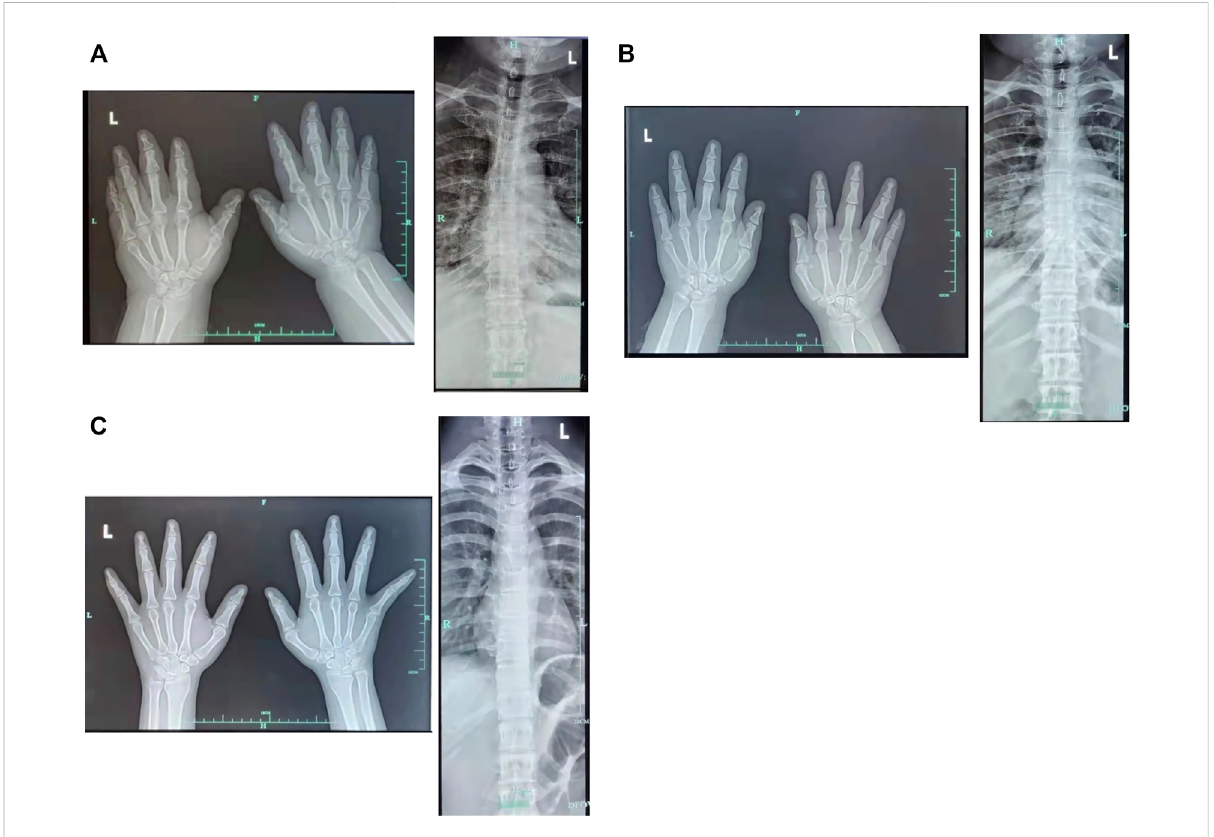
FIGURE 3 X-rays of hands and spines. (A) Mother (B) Elder sister (C)